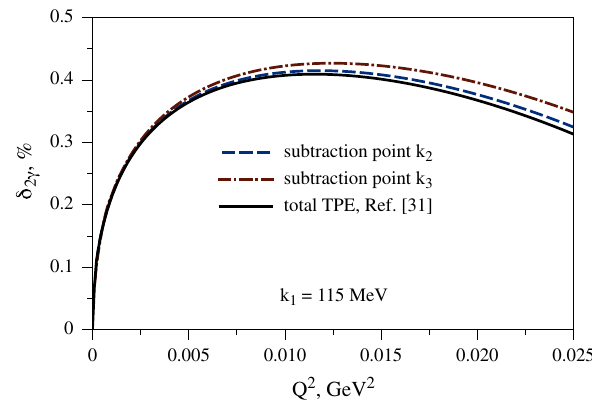
Fig. 7 TheTPEcorrectiontotheunpolarizedelastic μ − p crosssection within the subtracted DR framework is compared with the model result of Ref. [31] for the MUSE beam momentum k 1 = 115